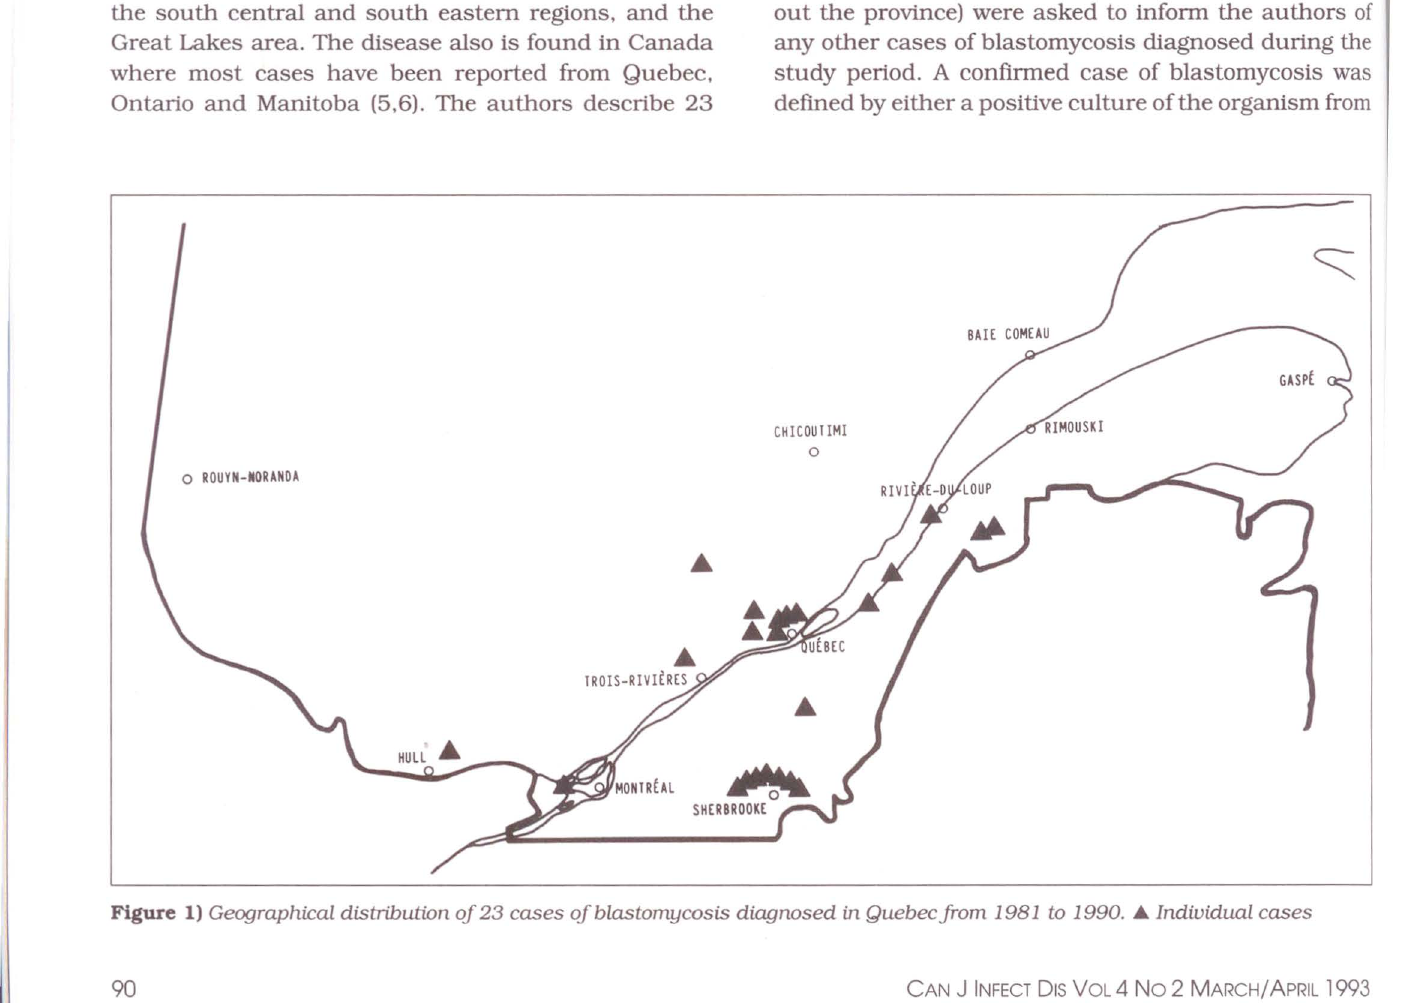
Figure 1) Geographical distribution of23 cases of blastomycosis diagnosed in Quebecjrom 1981 to 1990 . .A. Individual